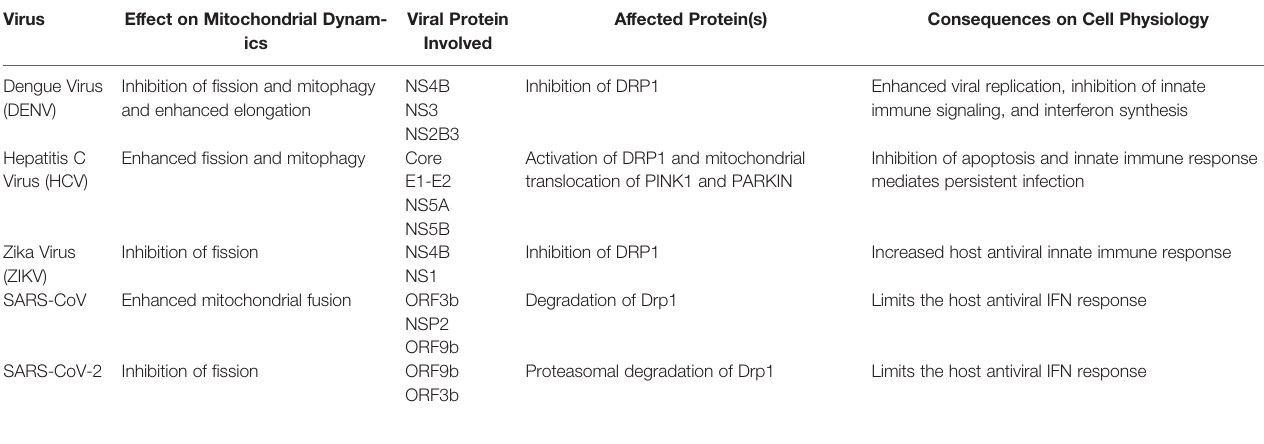
TABLE 1 | Involvement of Flaviviruses and the role of viral proteins in causing an alteration in mitochondrial dynamics.